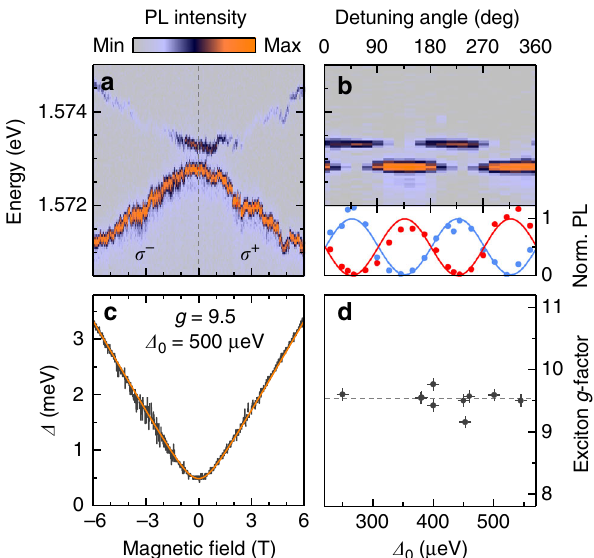
Fig. 5 Quantum dots in bilayer WSe 2 . a False-color plot of quantum dot magneto-luminescence under σ + ( σ − ) polarized excitation for positive (negative) magnetic fi elds in Faraday geometry. b The quantum dot emission doublet (upper panel) is characterized by linearly polarized peaks with orthogonal polarization axes (lower panel; note the anti-correlation in the intensities of the higher- and lower-energy peaks shown in red and blue together with squared sine and cosine fi ts). c Energy dispersion of the doublet splitting Δ in magnetic fi eld. Best fi t to the data with a hyperbolic function (solid line) was obtained for a zero- fi eld fi ne-structure splitting Δ 0 of 500 μ eV and an exciton g -factor of 9.5. d Distribution of exciton g - factors around the mean value of 9.5 plotted for ten quantum dots with respect to their zero- fi eld